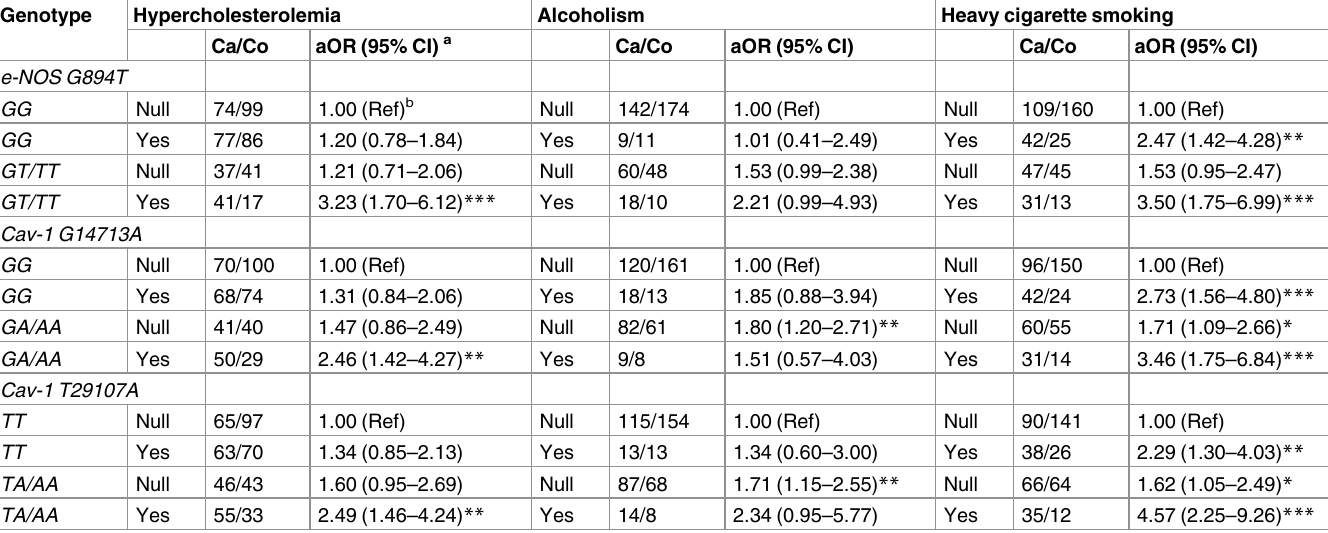
a aORs and 95% CIs were calculated in a logistic regression model after adjusting for age and gender of IS patients. b Ref, represents the reference group, indicating 894GG in e-NOS as well as 14713GG and 29107TT in Cav-1 ,